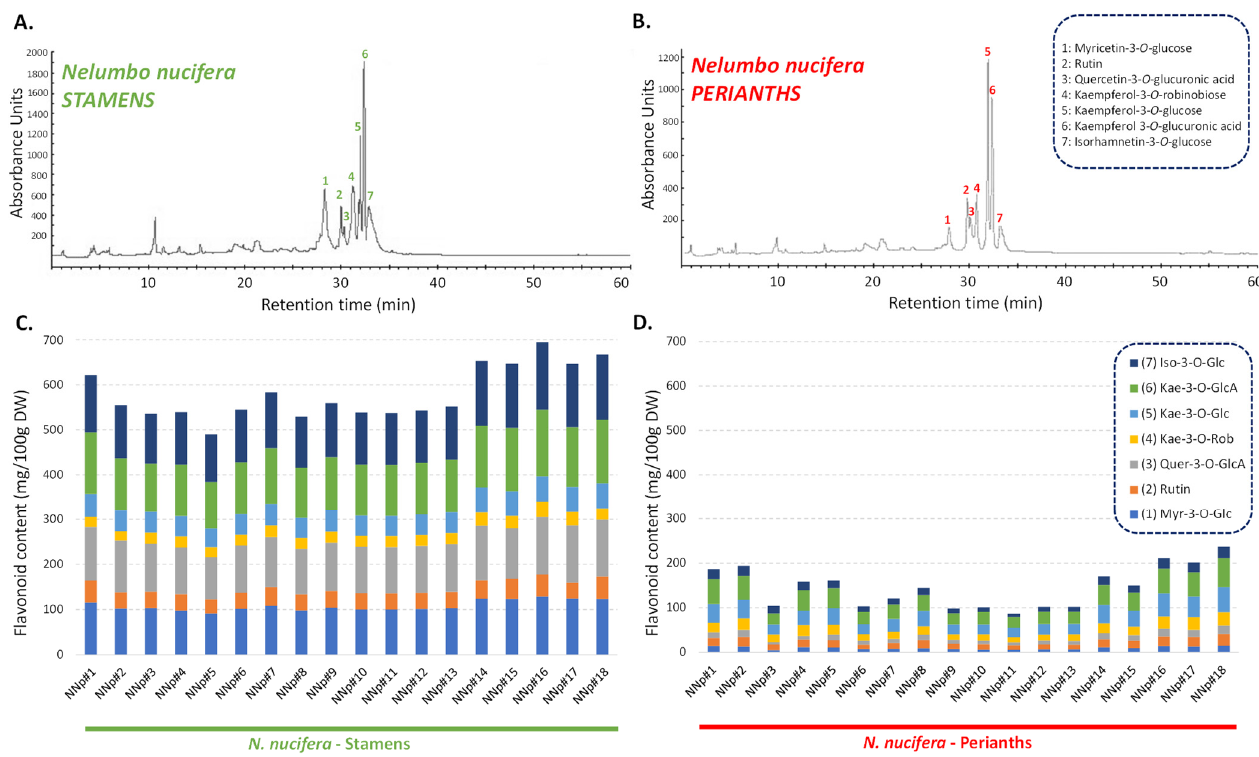
Figure 4. HPLC chromatograms (recorded at 320 nm) of the the stamen ( A ) and perianth ( B ) extracts of 18 N. nucifera populations originating from various floristic regions from Thailand. Quantification of the main flavonoids in the stamen ( C ) and perianth ( D ) extracts of 18 N. nucifera populations originating from various floristic regions from Thailand. Myr-3- O -Glc: myricetin-3- O -glucose; Quer-3- O -GlcA: quercetin-3- O -glucuronic acid; Kae-3- O -Rob: kaempferol-3- O -robinobiose; Kae-3- O -Glc: kaempferol-3- O -glucose; Kae 3- O -GlcA: kaempferol 3- O -glucuronic acid; Iso-3- O -Glc: isorhamnetin-3- O -glucose; the mean and standard deviation of the concentration of each flavonoid is provided in Table S1. Individual flavonoid concentrations varied from 5.0 (myricetin-3- O -glucose, P#3) to 149.9 (isorhamnetin-3- O -glucose, S#16) mg/100 g DW in N. nucifera extracts.